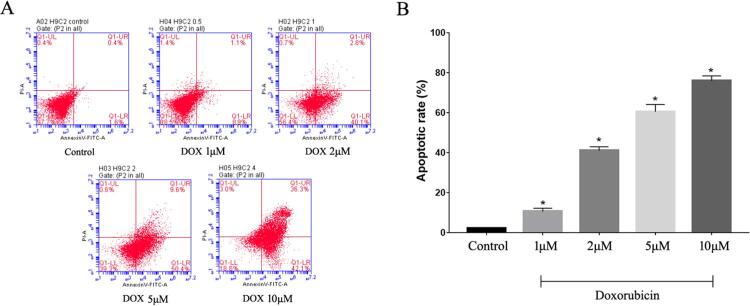
– Flow cytometry analysis to evaluate the effects of doxorubicin on H9c2 cell viability. H9c2 cells were pretreated with saline (control) and doxorubicin at 1, 2, 5 and 10μM, respectively, for 24h. (A) Representative flow cytometry analyses of five individual experiments corresponding to control and different concentration doxorubicin treatment, respectively. (B) Statistical graph of annexin V-FITC/PI staining. Results was expressed as mean±SD. * p<0.01 vs control group.